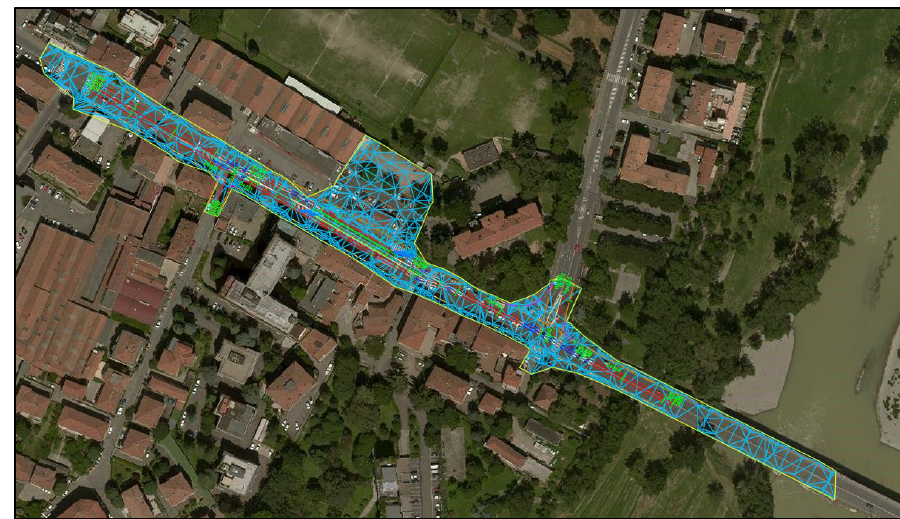
Figure 3. Topographical survey of the area case of study.